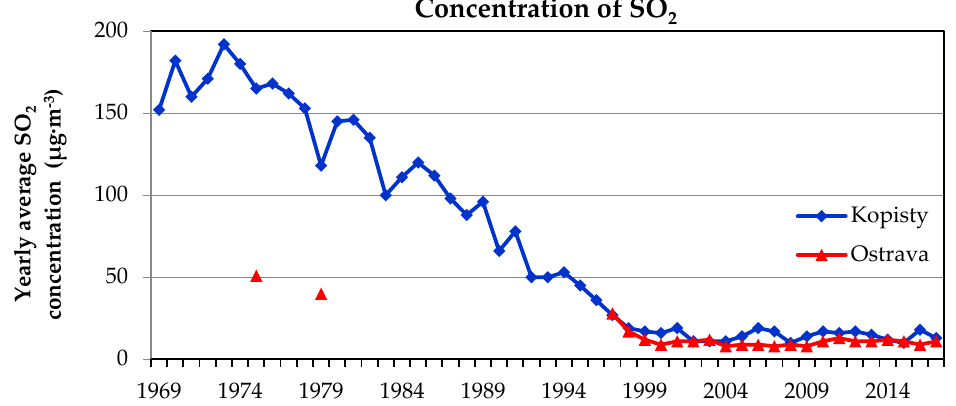
Figure 2. Decreasing of concentration of SO 2 in locality Kopisty and Ostrava (Czech Republic).